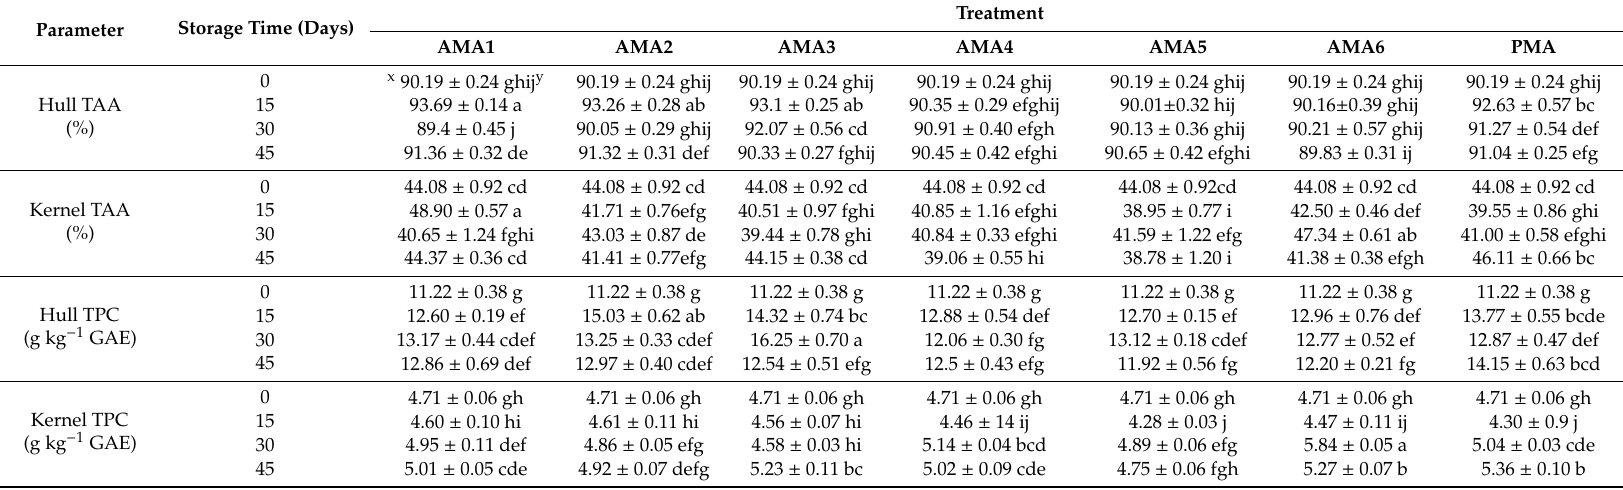
Table 4. E ff ect of di ff erent AMA and PMA conditions on the hull’s total antioxidant activity (Hull TAA), kernel’s total antioxidant activity (Kernel TAA), hull’s total phenolic compounds (Hull TPC), and kernel’s total phenolic compounds (Kernel TPC) of fresh in-hull pistachios stored for 45 days at 4 ± 1 ◦ C and 90 ± 5%